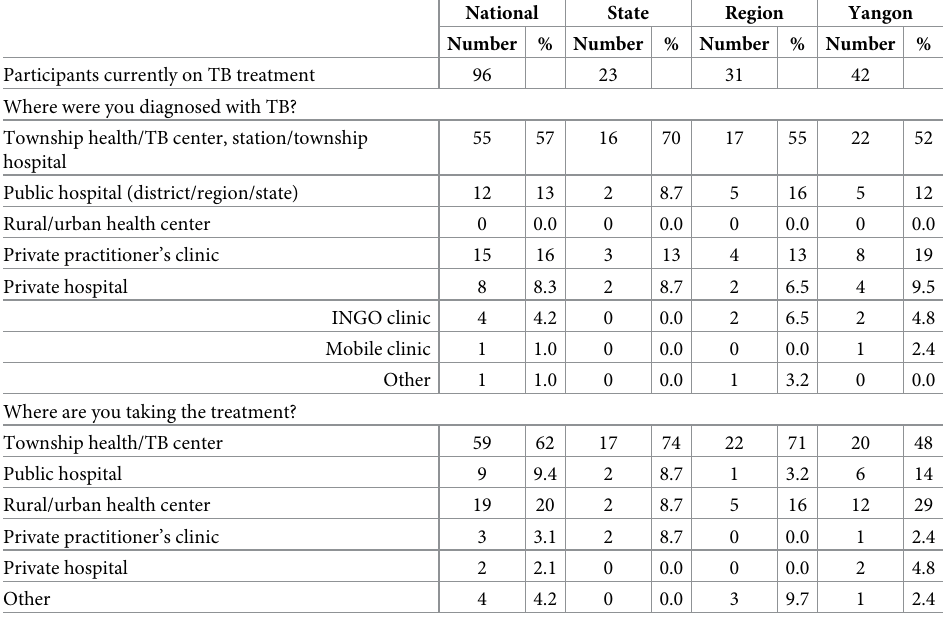
Table 5. Type of facility used by participants currently on TB